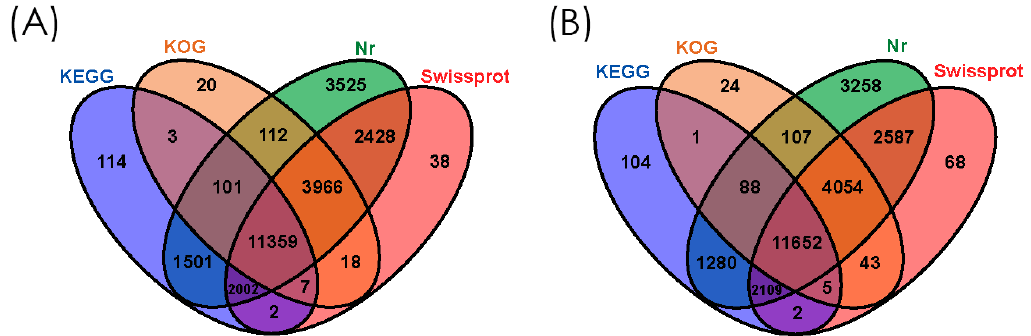
Figure 2. Venn diagrams showing the unigene assembly BLAST results of Anser anser ( A ) and Anser cygnoides ( B ) transcriptome against four databases. These show the differences and similarities of the number of unigenes annotated in each database within the individual species and between different species.